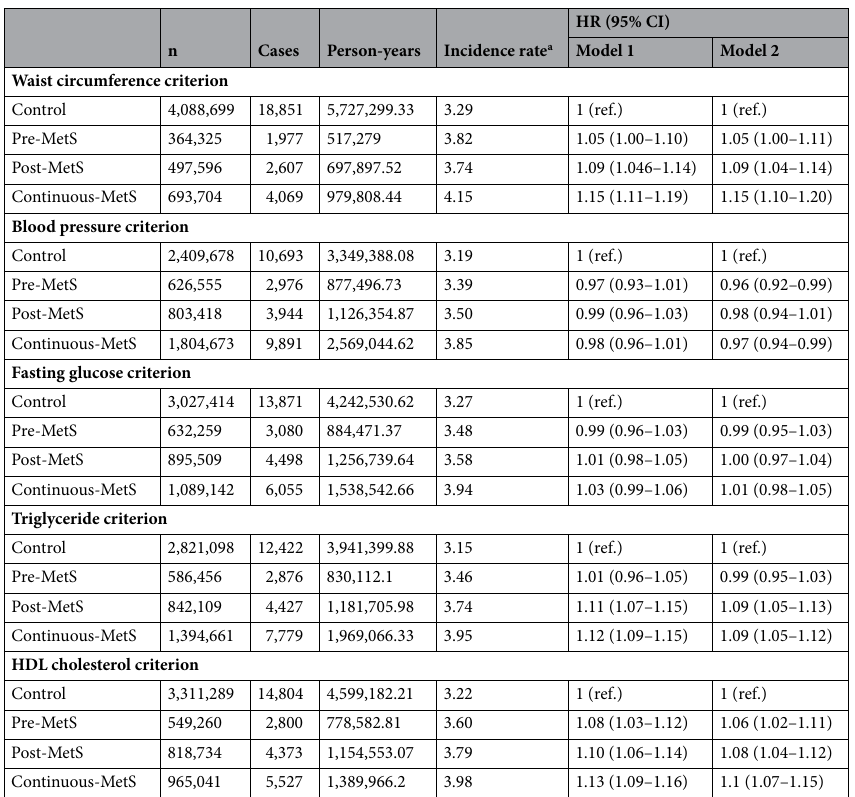
Table 3. Multivariable HRs of psoriasis risk according to MetS component diagnosis changes (CI, confidence interval; HR, hazard ratio). Values are expressed as HRs (95% CIs) based on Cox proportional hazard regression analysis. Model 1: adjusted for age and sex. Model 2: adjusted for age, sex, smoking, alcohol consumption statuses, physical activity, and BMI. a per 1,000 person-years. BMI, body mass index; CI, confidence interval; HR, hazard ratio; MetS, metabolic